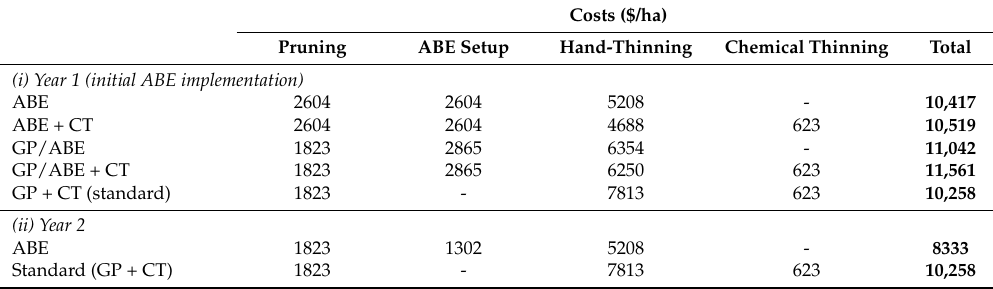
Table 14. Cost comparison for treatments applied in Trial 4. ABE = Artificial Spur Extinction, GP = grower prune, CT = chemical